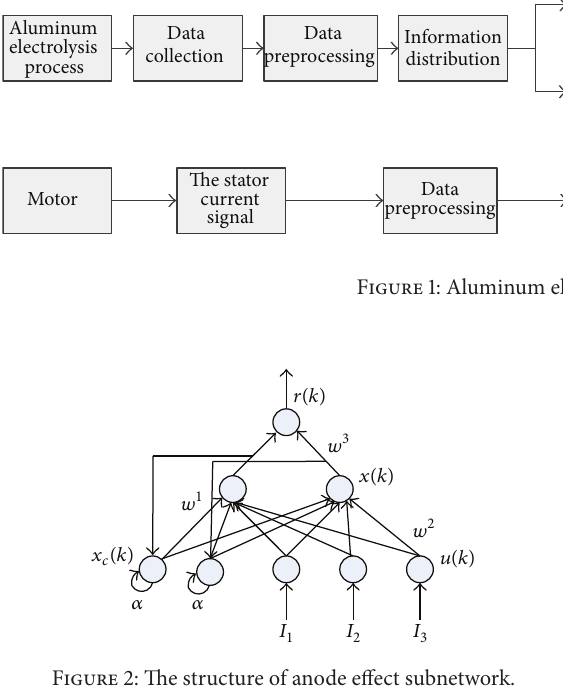
Figure 2: The structure of anode effect